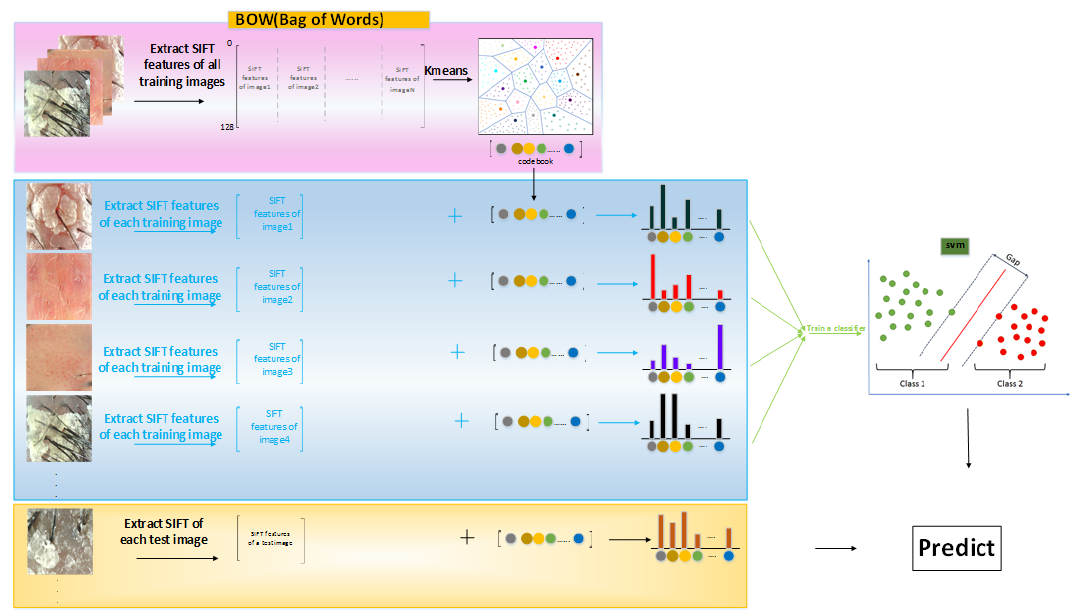
Figure 5. Bag of Words (BOW) with the support vector machine (SVM) method.